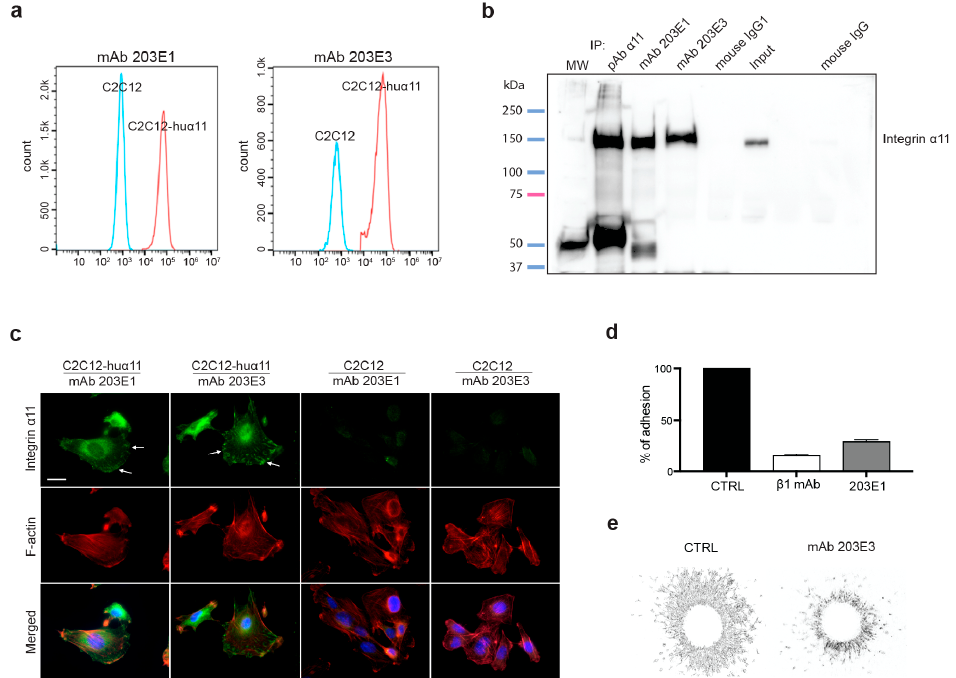
Figure 1. Characterization of the α 11 mAb 203E1 and the mAb 203E3. ( a ) Characterization by flow cytometry. C2C12 cells and C2C12 expressing human α 11 integrin (C2C12-hu α 11) cells were subjected to flow cytometry using the 203E1 and 203E3 mAbs. Only the C2C12-hu α 11 cells incubated with the 203E1 and 203E3 mAbs displayed a fluorescence shift. ( b ) Characterization by immunoprecipitation. Integrin α 11 β 1 was immunoprecipitated with the 203E1 and 203E3 mAbs. The polyclonal α 11 antibody (pAb α 11) was used as a positive control, whereas mouse IgG1 was used as a negative control. Loading of the cell lysis (input) has been included to appreciate the e ffi ciency of the immunoprecipitation. Immunoprecipitated proteins were detected with a rabbit polyclonal antibody to human α 11. The full-size Western blotting is presented, MW: molecular weight marker. ( c ) Characterization by immunocytochemistry. C2C12 and C2C12-hu α 11 cells were plated on collagen I and immunostained using mAbs 203E1 and 203E3. Both antibodies immunostained focal adhesions (arrows). Scale bar: 20 µ m. ( d ) Characterization in cell adhesion assay. C2C12-hu α 11 cells were incubated with either β 1 mAb or 203E1 mAb and allowed to adhere to collagen I. ( e ) Characterization in invasion assay. Homospheroids composed of C2C12-hu α 11 cells were embedded in collagen I gel and treated with either the mouse IgG1 isotype control or 203E1 mAb at 10 µ g / mL. Spheroid migration was analyzed after 24 h.